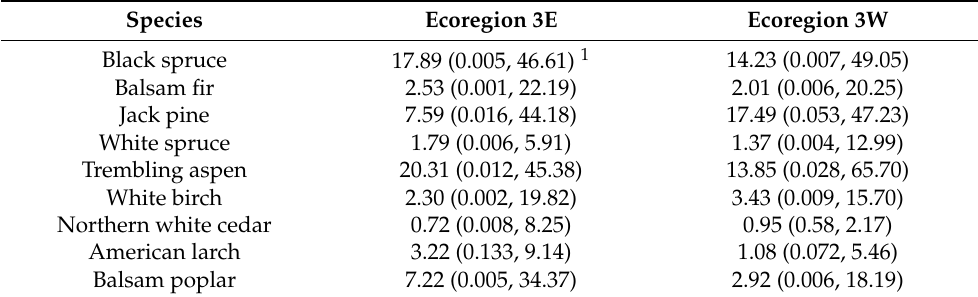
Table 1. Average basal area (m 2 ha − 1 ) for tree species by ecoregion included in the study in northern Ontario,